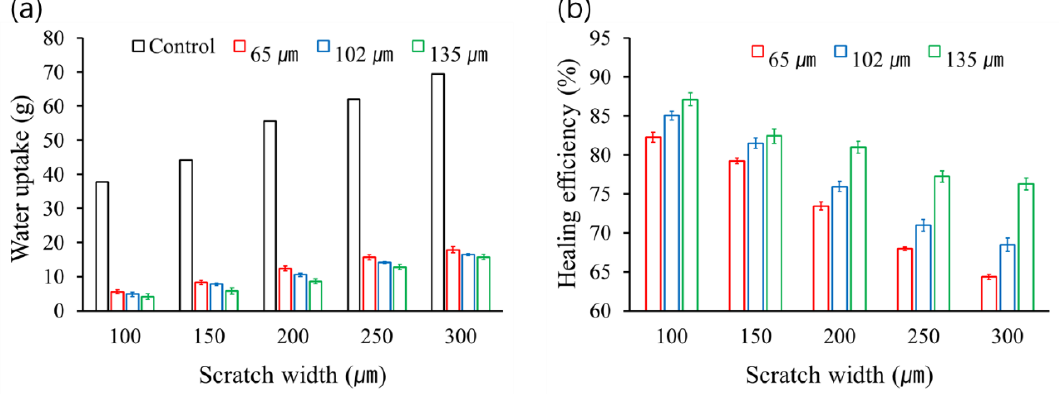
Figure 4. ( a ) Water uptake versus scratch width of the control and self-healing coatings containing microcapsules with mean diameter of 65, 102 or 135 µm; ( b ) Healing efficiency versus scratch width of the self-healing coatings containing microcapsules with mean diameter of 65, 102 or 135 µm. Capsule-loading of the self-healing coating was 20 wt% and undercoating thickness was 50 µm.